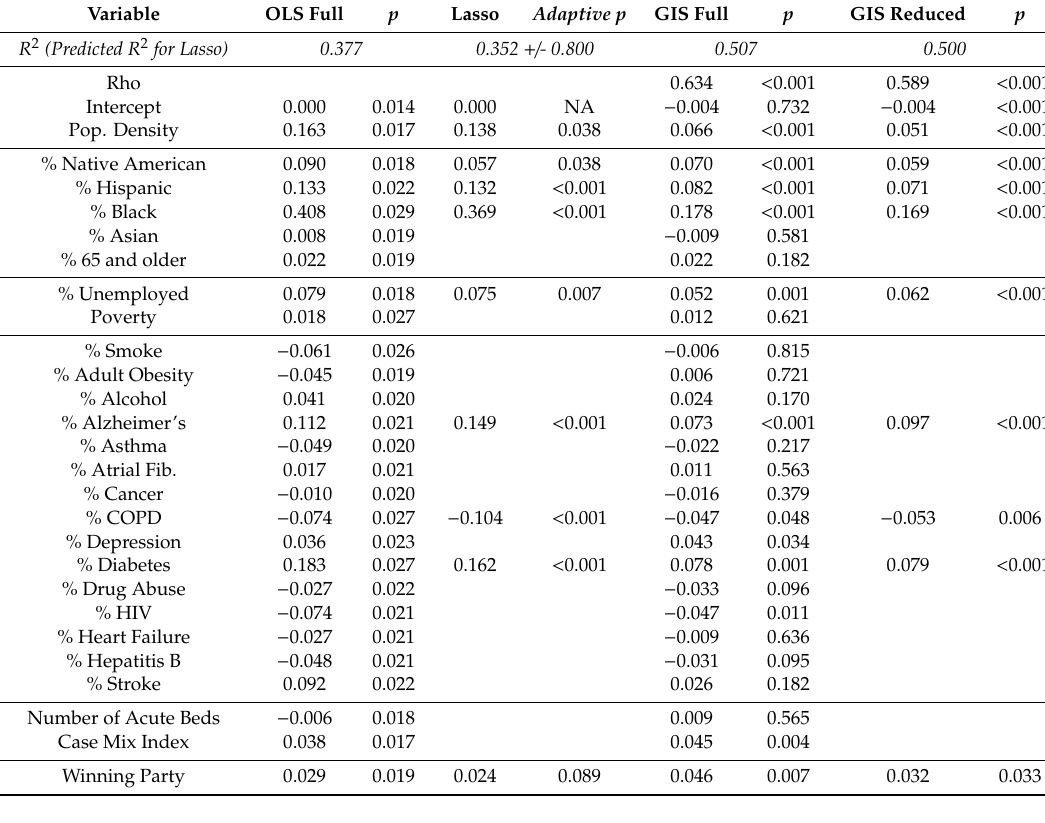
Table 4. Model results (scaled variables).